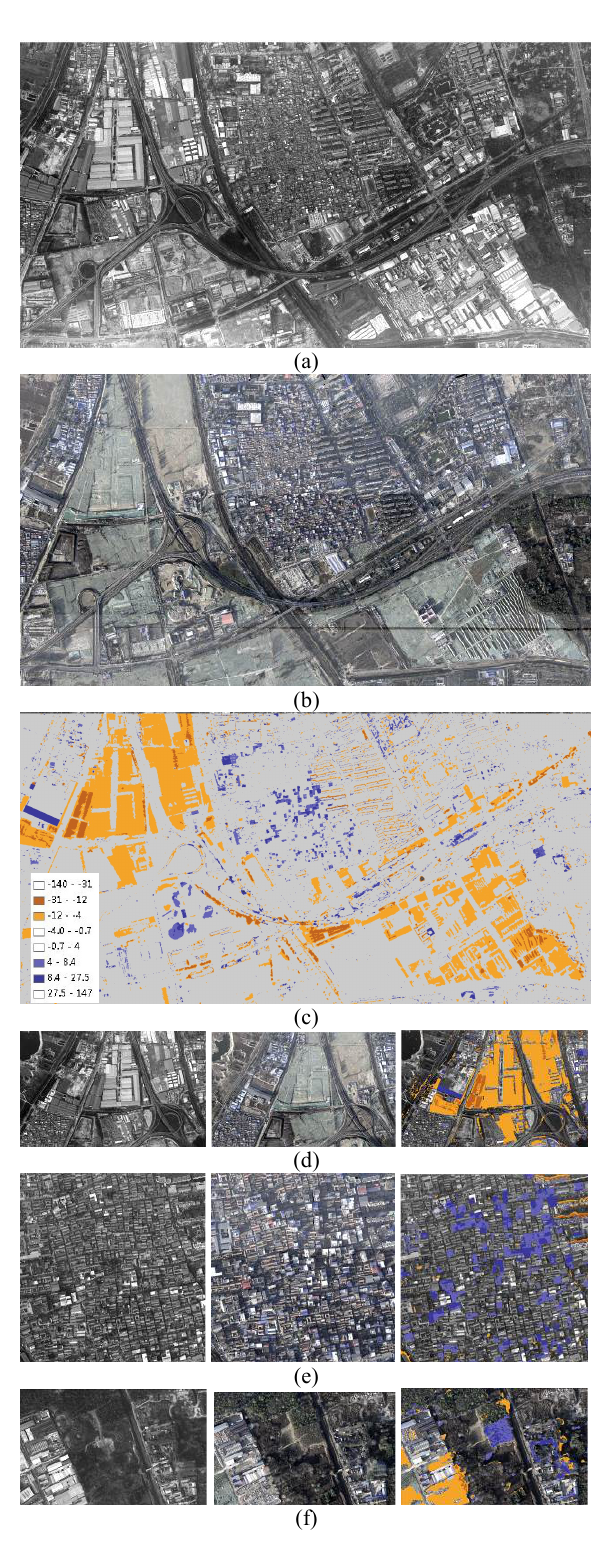
Figure 5. Change detection result with DSM. (a) TDOM of 2016, (b) TDOM of 2017, (c) DSM difference result between 2016 and 2017, (d) two period TDOM data and DSM difference result of construction area, (e) two period TDOM data and DSM difference result of built-up area, (f) two period TDOM data and DSM difference result of regional